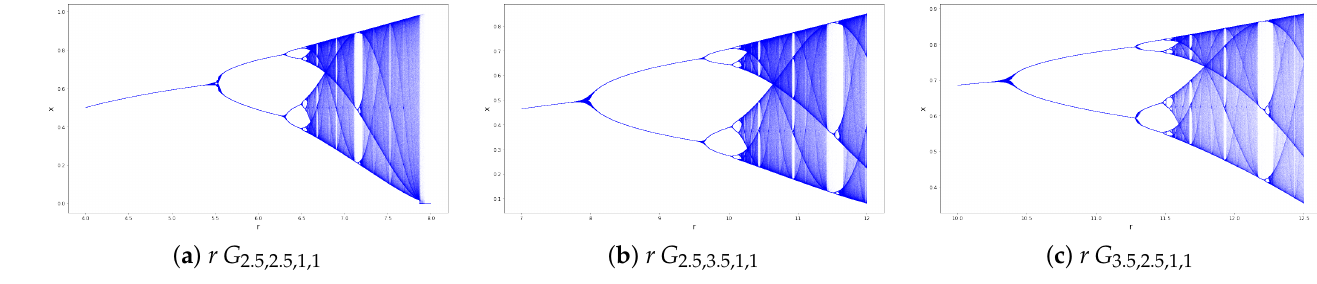
Figure 7. Hyper-logistic bifurcation diagrams.